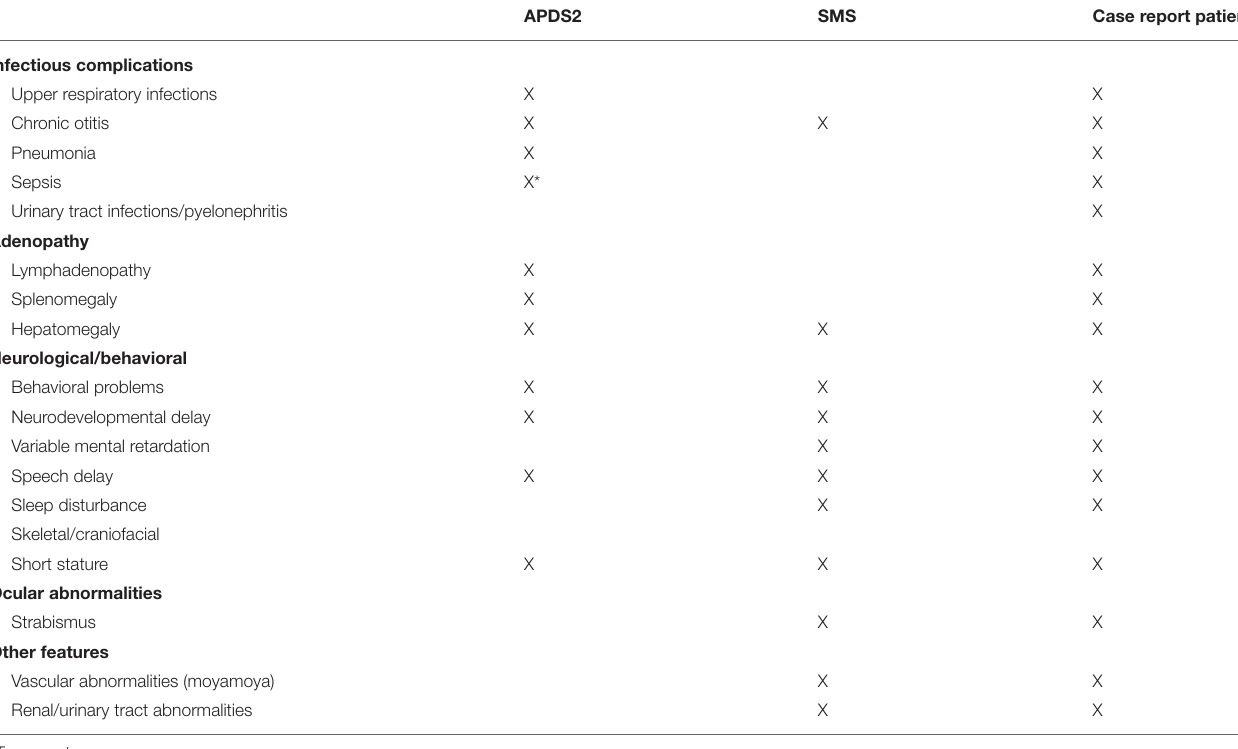
TABLE 2 | Clinical features of APDS2, SMS, and reported patient.